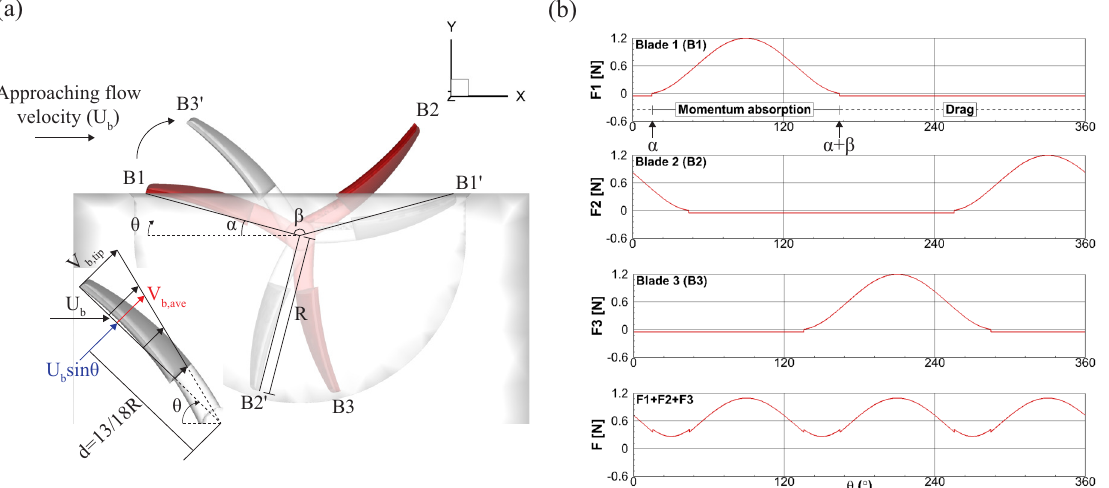
Figure 5. ( a ) Schematic view of power coefficient estimation model and ( b ) expected drag force ( F ) at the optimal tip speed ratio ( λ = 0.32), estimated by the forces on the three blades ( F 1,2,3 ). Measured and calculated power coefficient curves are plotted in Figure 6. As reported in previous experiments on a lift force-driven vertical axis hydrokinetic turbine, there were uncertainties in obtaining torque values because the generated torque in the turbine model was in the proximity of the lower limit of the measurement range for the torque transducer [25], requiring additional gears. Small sediment particles and organic material present in the Mississippi River water also added uncertainties, as they intermittently induced variability in mechanical friction of the bearing system. Therefore, the ensemble average of the repeated torque measurement for 5 times (solid line) and their minimum and maximum range (dashed line) are presented. Torque measurements were